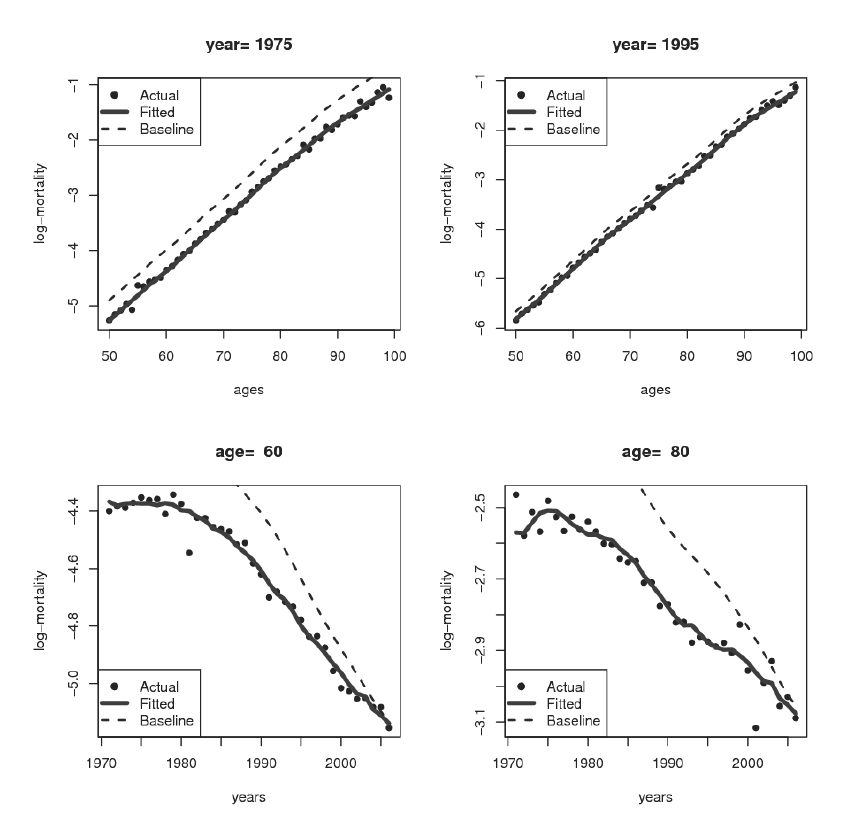
Figura 10 – Observed and fitted mortality rates for selected years and ages. Ip = H and Ic = m 1-4 . Italy,